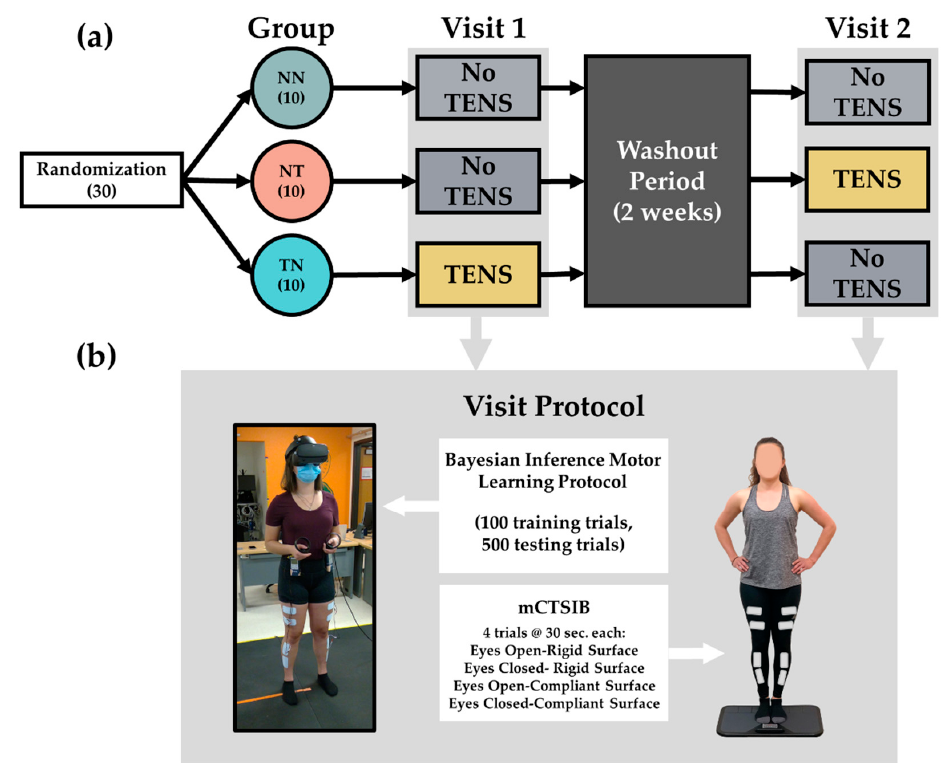
Figure 1. Study design and protocol. ( a ) Thirty healthy young participants were pseudo-randomly assigned to one of three study groups. The NN group received no TENS on either visit. The NT group received TENS only on their second visit. The TN group received TENS on their first visit. ( b ) Visit protocol involved the completion of a motor learning protocol performed in virtual reality as well as the completion of the modified clinical test of sensory integration for balance (mCTSIB). All participants were assigned to one of three study groups (accounting for balanced representations of male/females). Group NN (no TENS/no Tens) received no TENS stim- ulation on either of their study visits. Group NT (no TENS/TENS) received TENS stimu- lation on only their second visit. Group TN (TENS/no TENS) received TENS stimulation on their first visit only. All participants were healthy with no serious injuries or ailments limiting their physical abilities. A complete description of the participant and group de- mographics and characteristics can be found in Table 1.